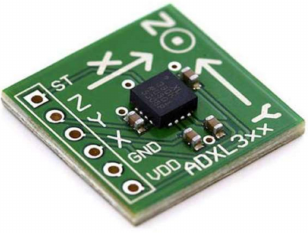
Figure 10. The ADXL335 3-axis ACC with a three-output analog pin x, y, and z